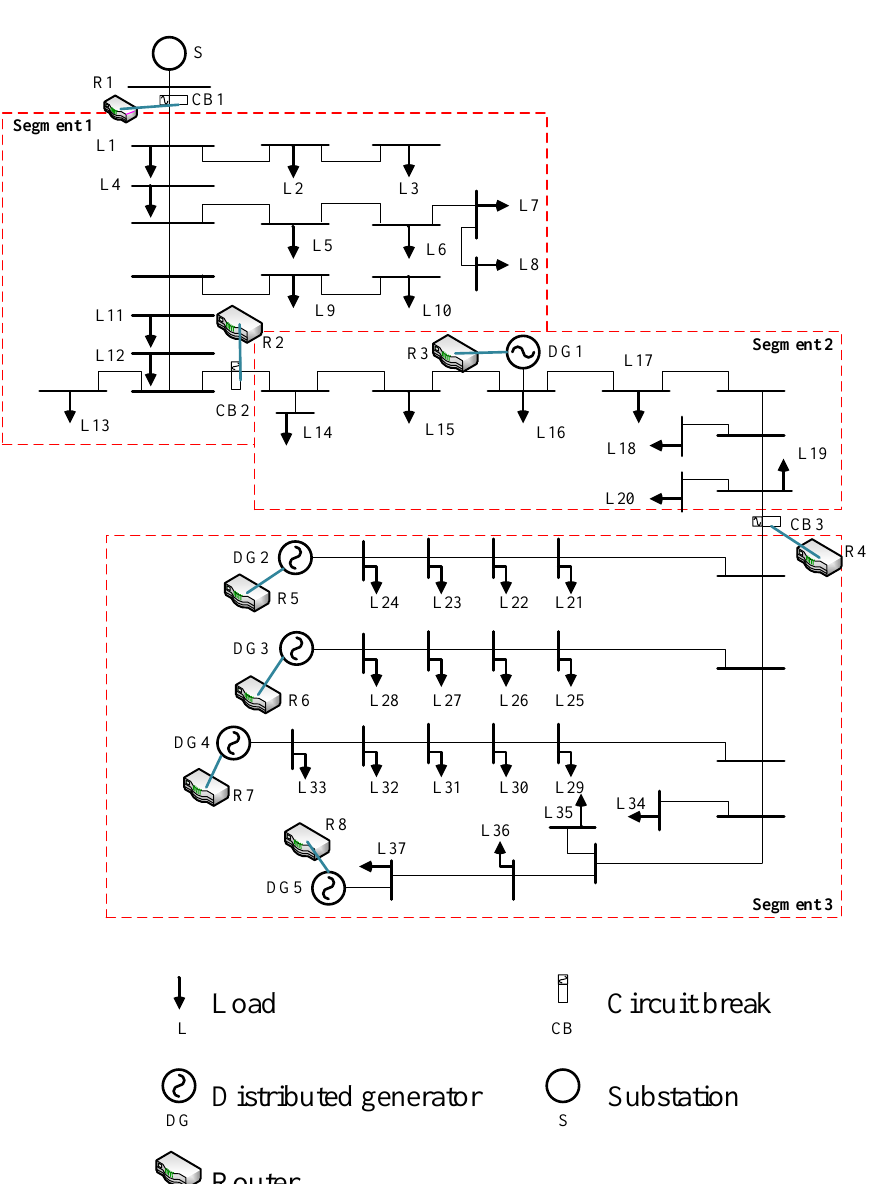
Figure 3. The diagram of 20 kV feeder in Sirjan City of Iran. For any cyber and physical device in CPPS, there are two states: up and down. To investigate the impact of device state on systems reliability, the hourly state of devices must be determined. The up and down states of devices can be generated by simulating their failures and repairs based on historical data [31],